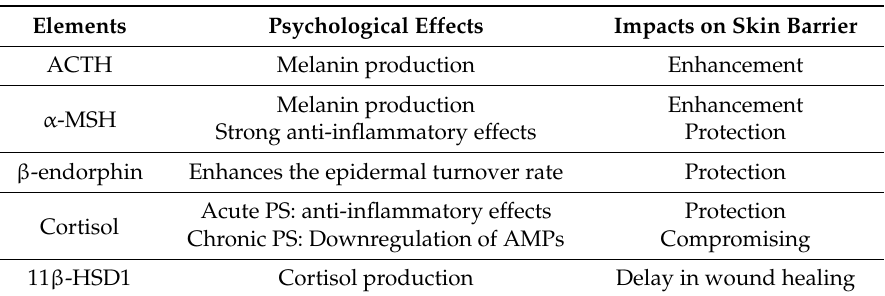
Table 1. Effects of peripheral HPA on skin